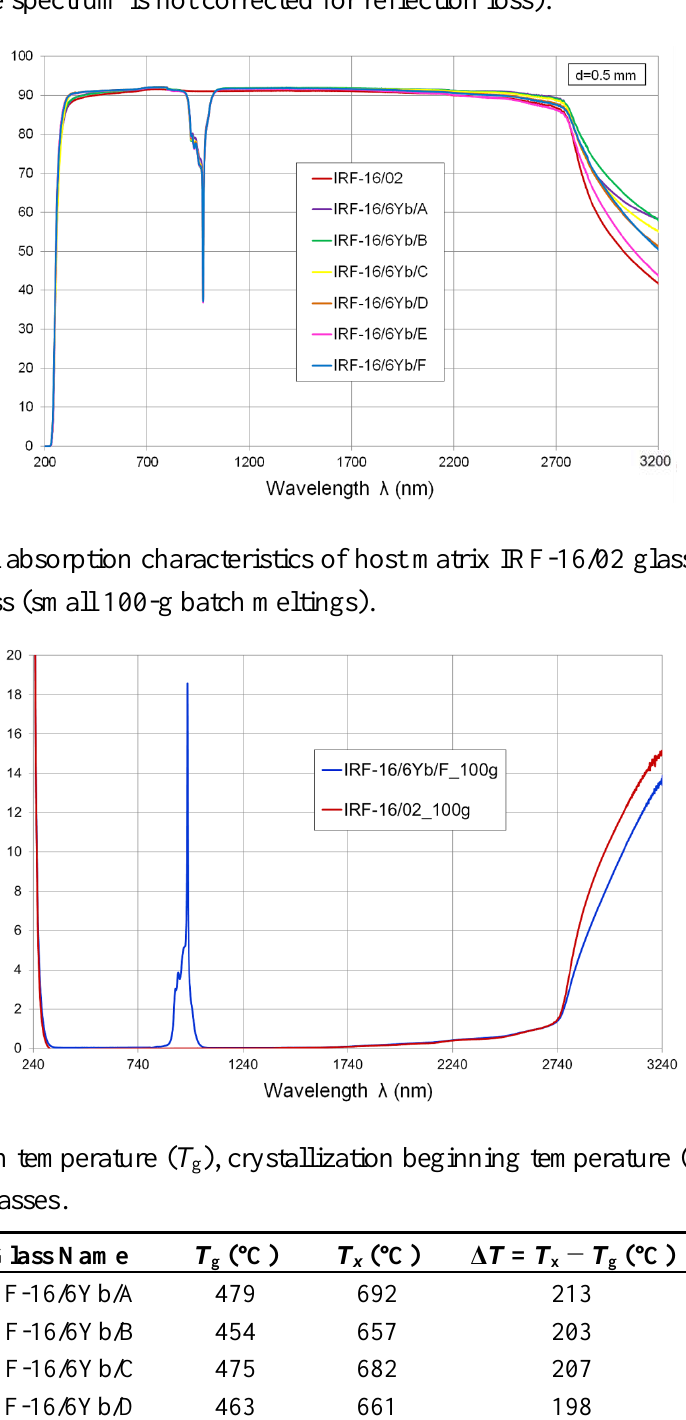
Figure 1. Transmittance of IRF-16/6Yb/A-F series glasses and IRF-16/02 glass from 100-g batch meltings (the spectrum is not corrected for reflection loss).